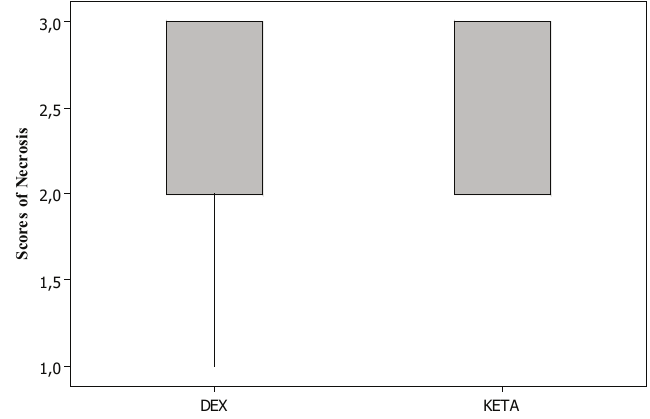
FIGURE 3 - Scores of necrosis in the left kidney (data reported as median, 25 th and 75 th percentile), 48 hour after ischemia-reperfusion, according to group (dex and keta); p=0.90; Dex =